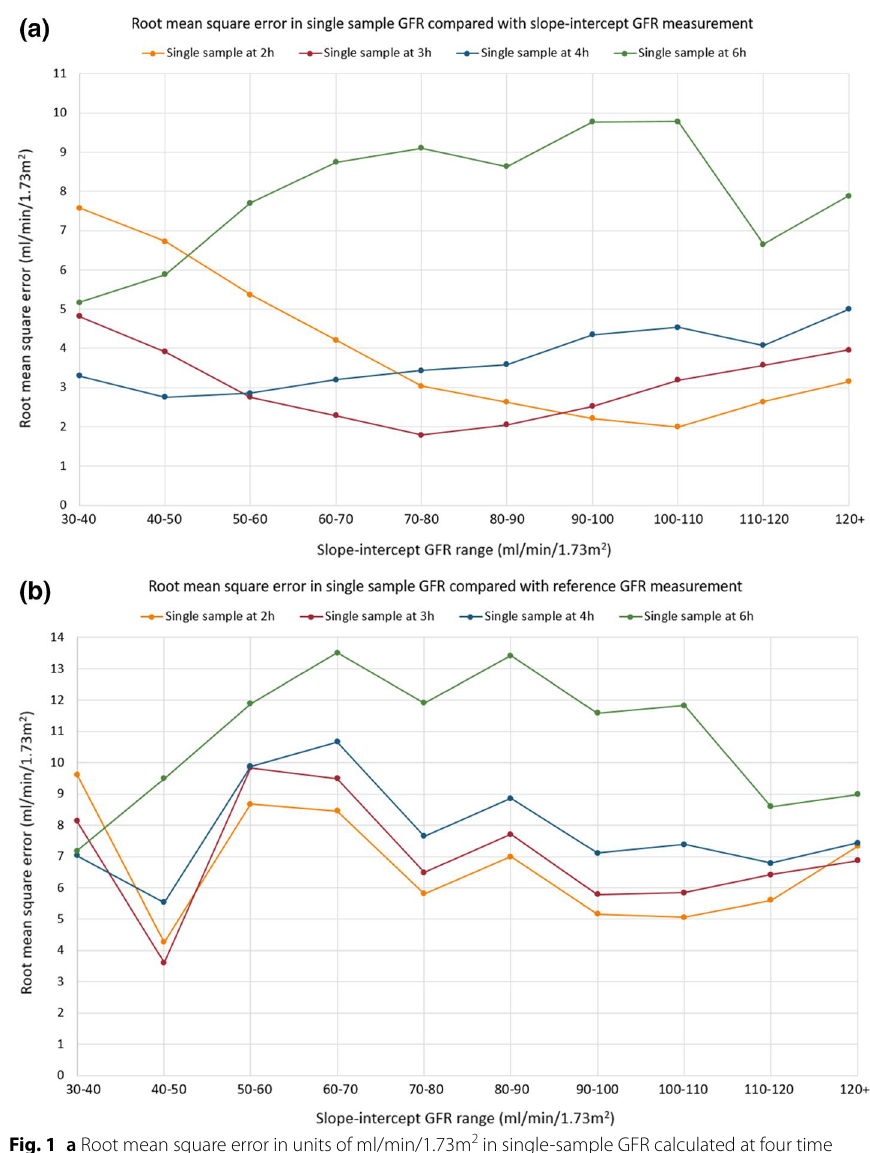
points compared with slope–intercept GFR for each slope–intercept GFR range. b Root mean square error in units of ml/min/1.73m 2 in single-sample GFR calculated at four time points compared with reference GFR